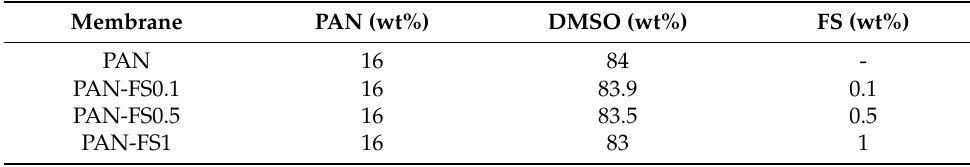
Table 1. Composition of the prepared flat sheet